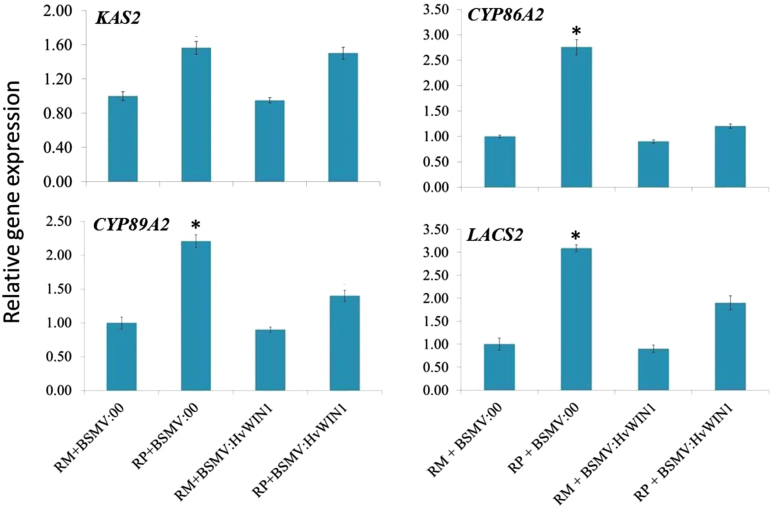
Effect of HvWIN1 silencing on relative transcript expression of downstream target genes. The relative transcript expression at 72 hpi was measured by comparing the expression with mock-inoculated resistant genotype. RM, mock-treated resistant genotype samples; RP, pathogen-treated resistant genotype samples; BSMV:00, barley plants rub-inoculated with negative control; BSMV:HvWIN1, barley plants rub-inoculated with BSMV vector containing HvWIN1. Significant differences in expression levels in RP+BSMV:00 compared with RP+BSMV:HvWIN1 using student’s t-test: *, P<0.05. A colour version of this figure is available at JXB online.